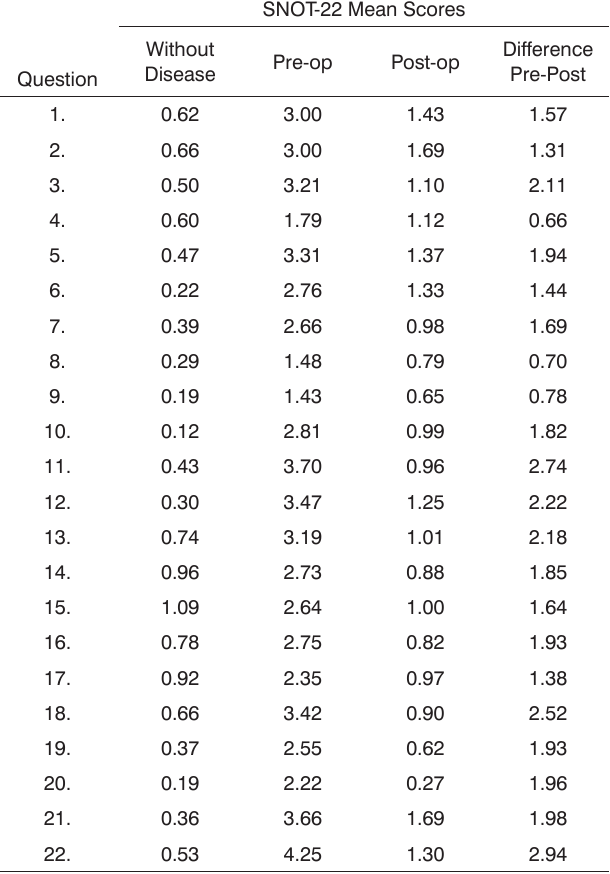
Table 4. Mean scores by question per group